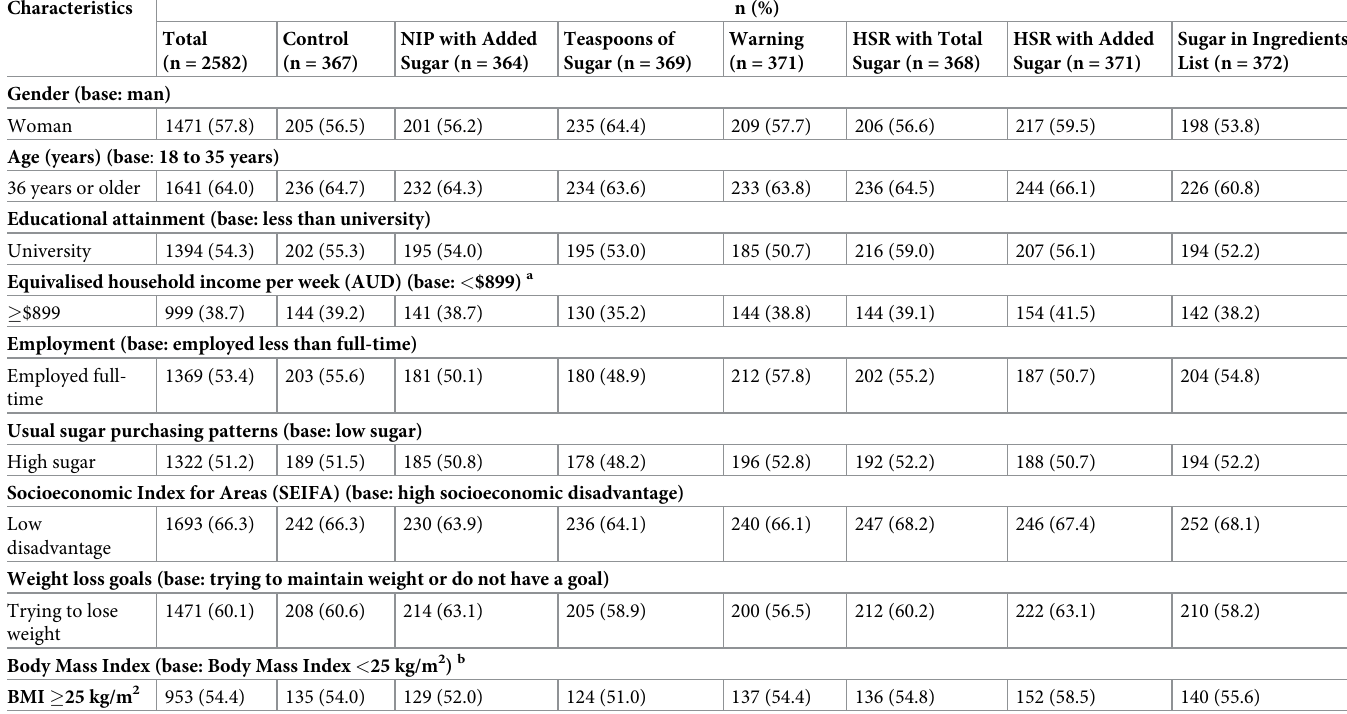
Table 1. Participant demographic characteristics across labelling